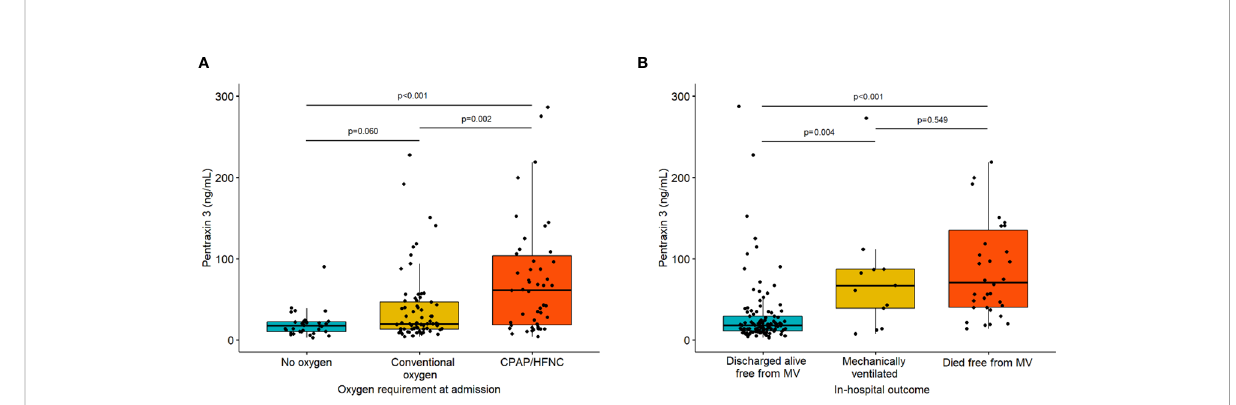
FIGURE 1 Baseline PTX3 levels according to oxygen requirement at admission (Panel A ) and in-hospital outcome (panel B ). P-values are from pairwise Mann-Whitney tests with Holm correction for multiplicity. List of abbreviations: MV, mechanical